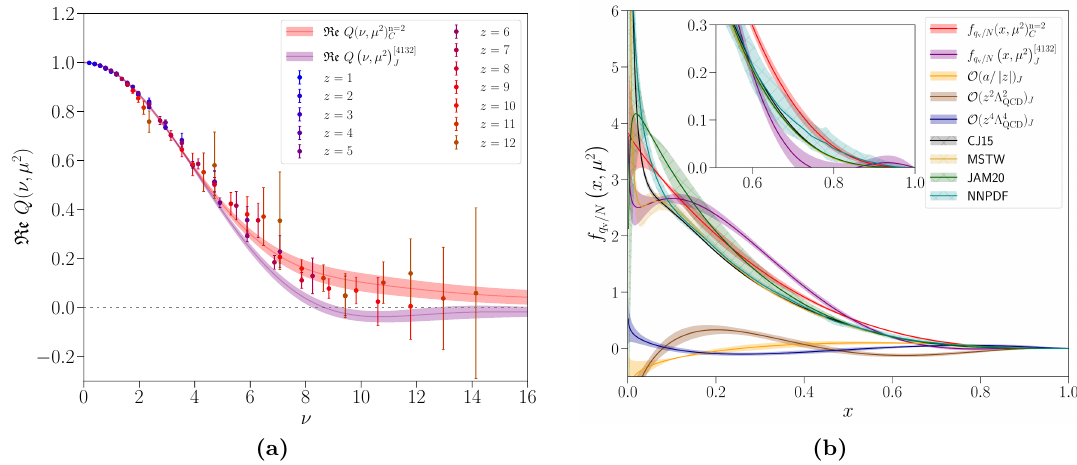
Figure 18. (a) The real component of the leading-twist ITD (purple) at 2 GeV derived from the Jacobi polynomial expansion of the reduced pseudo-ITD for z/a ≤ 12 with { n { 4 , 1 , 3 , 2 } v . The result is compared with the uncorrelated 2 -parameter phenomenological form of eq. (4.7) shown in red. (b) The valence quark leading-twist PDF (purple) obtained from the { n lt , n az , n t 4 , n t 6 } v = { 4 , 1 , 3 , 2 } v Jacobi polynomial expansion of the reduced pseudo-ITD. The a/ | z | (orange), twist- 4 (brown), and twist- 6 (navy) x -space distributions are also shown and seen to be sub-leading. The distributions are compared with the uncorrelated 2 -parameter phenomenological fit of eq. (4.7) (red), as well as the NLO global analyses of CJ15 [82] and JAM20 [88], and the NNLO analyses of MSTW [89] and NNPDF [87] at the same